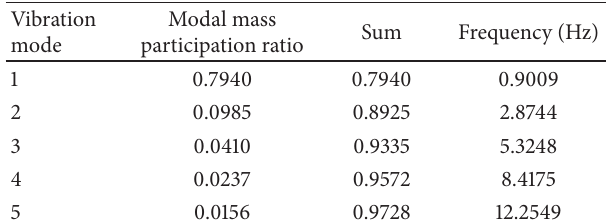
Table 2: Modal mass participation ratios and natural frequencies of the